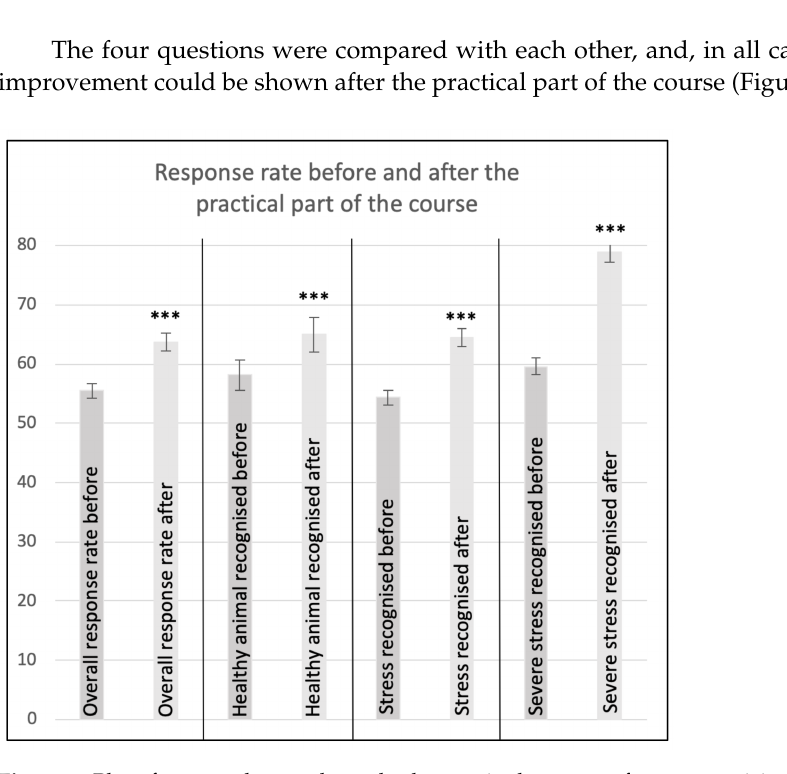
Figure 1. Plot of mean values and standard errors in the group of course participants before and after participation in practical teaching. Four arithmetical comparisons. Y -axis = mean values agreement with the answer in %. *** p -value < 0.001. With regards to the recognition of severely stressed animals, the highest increase in performance can be